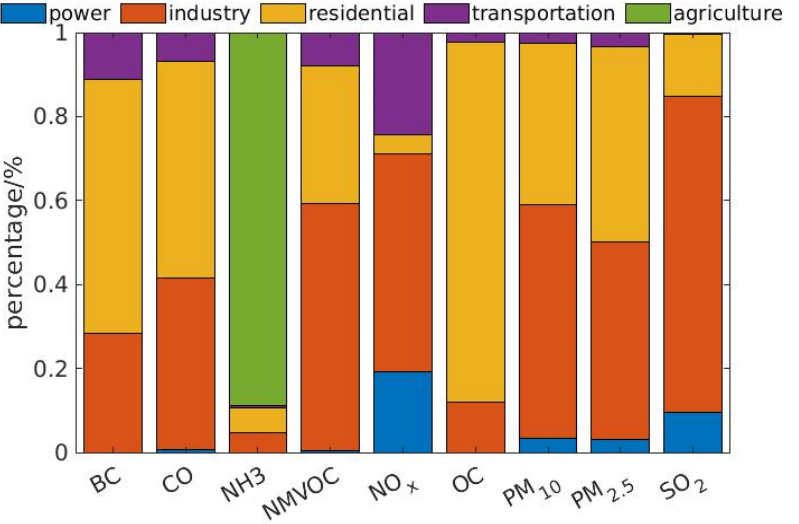
Figure 4. Emission inventory. The histogram shows the percentage of emission rate for the air pollutants in power, industry, residential, transportation, and agriculture sectors in Hubei Province.